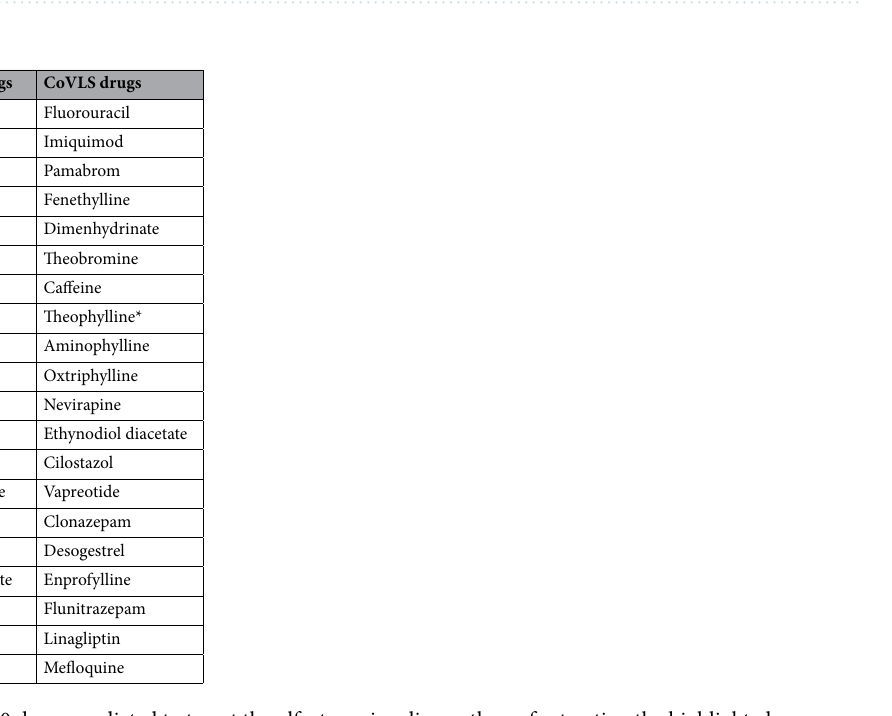
Table 6. Top 20 drugs predicted to target the olfactory signaling pathway for treating the highlighted symptom, loss of sense of smell. *Indicates the drug is currently undergoing clinical trials for loss of